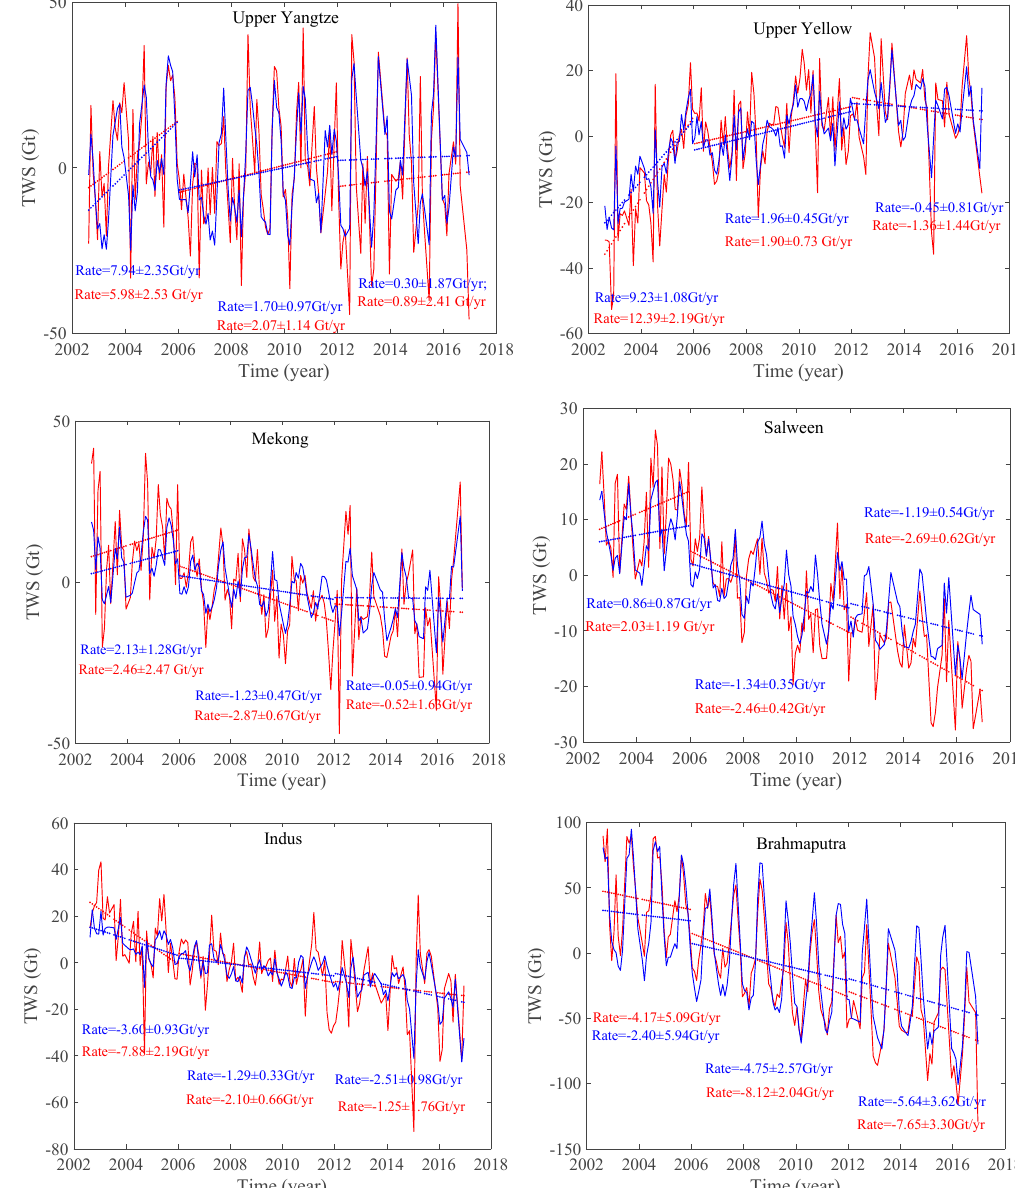
Figure 5. Time series of water storage variations in 10 basins (the inner TP, Qaidam basin, Tarim basin, Hexi basin, Upper Yangtze Basin, Upper Yellow River basin, Mekong Basin, Salween Basin, Indus basin and Brahmaputra Basin) of the Tibetan Plateau from August 2002 to December 2005, from January 2006 to December 2011, and from January 2012 to December 2016. The explanation of rates can see the legend in Figure 4.